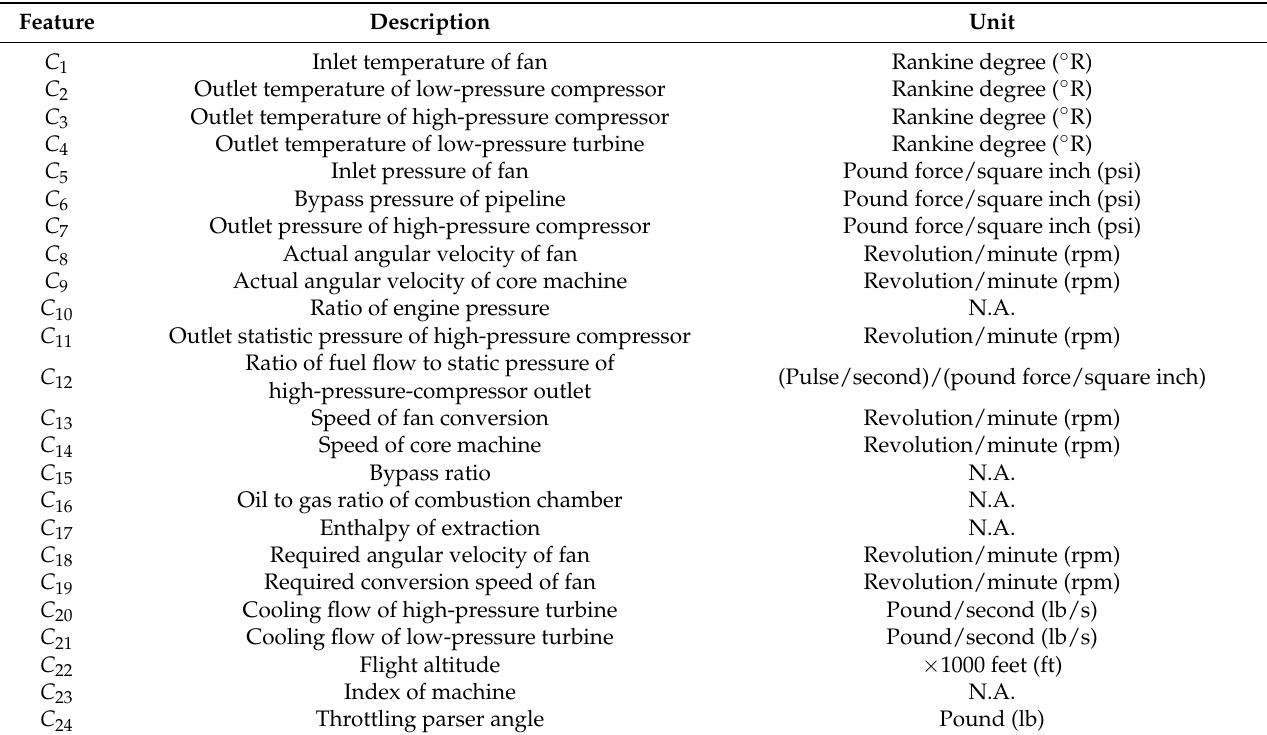
Table 4. Features from operating turbofan considered in this